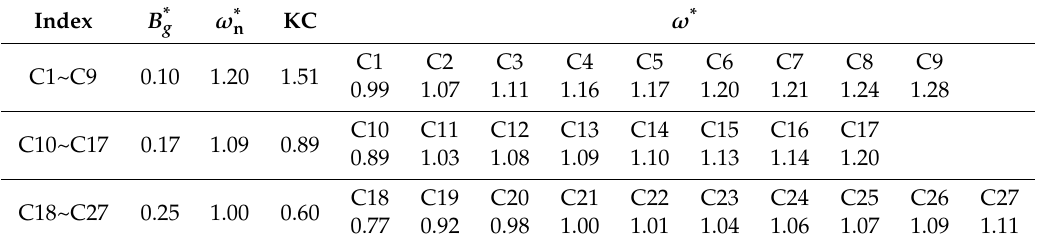
Table 1. Summary of the present numerical simulation